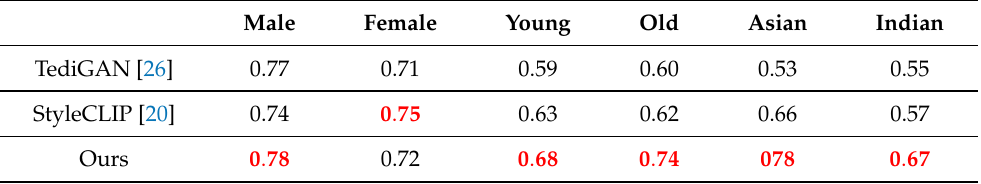
Figure 11. Comparison 1: conditional generation. Table 7. Comparison of our recognition ratios with those of existing studies. The red figures are maximum recognition ratio in each column.